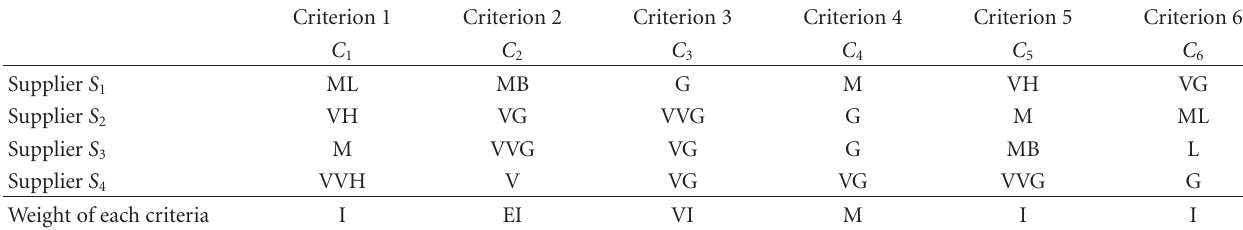
Table 5: Rating of the alternatives from decision maker 1 (DM 1 ).